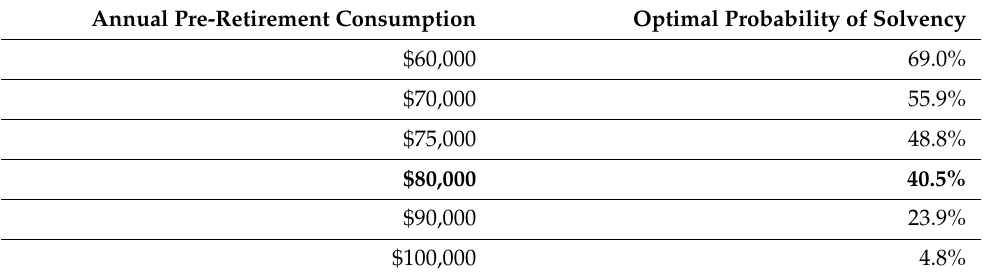
Table 14. The effect on Investor #2 of varying the pre-retirement consumption, in t = 0 post-tax dollars, from its normal value (in